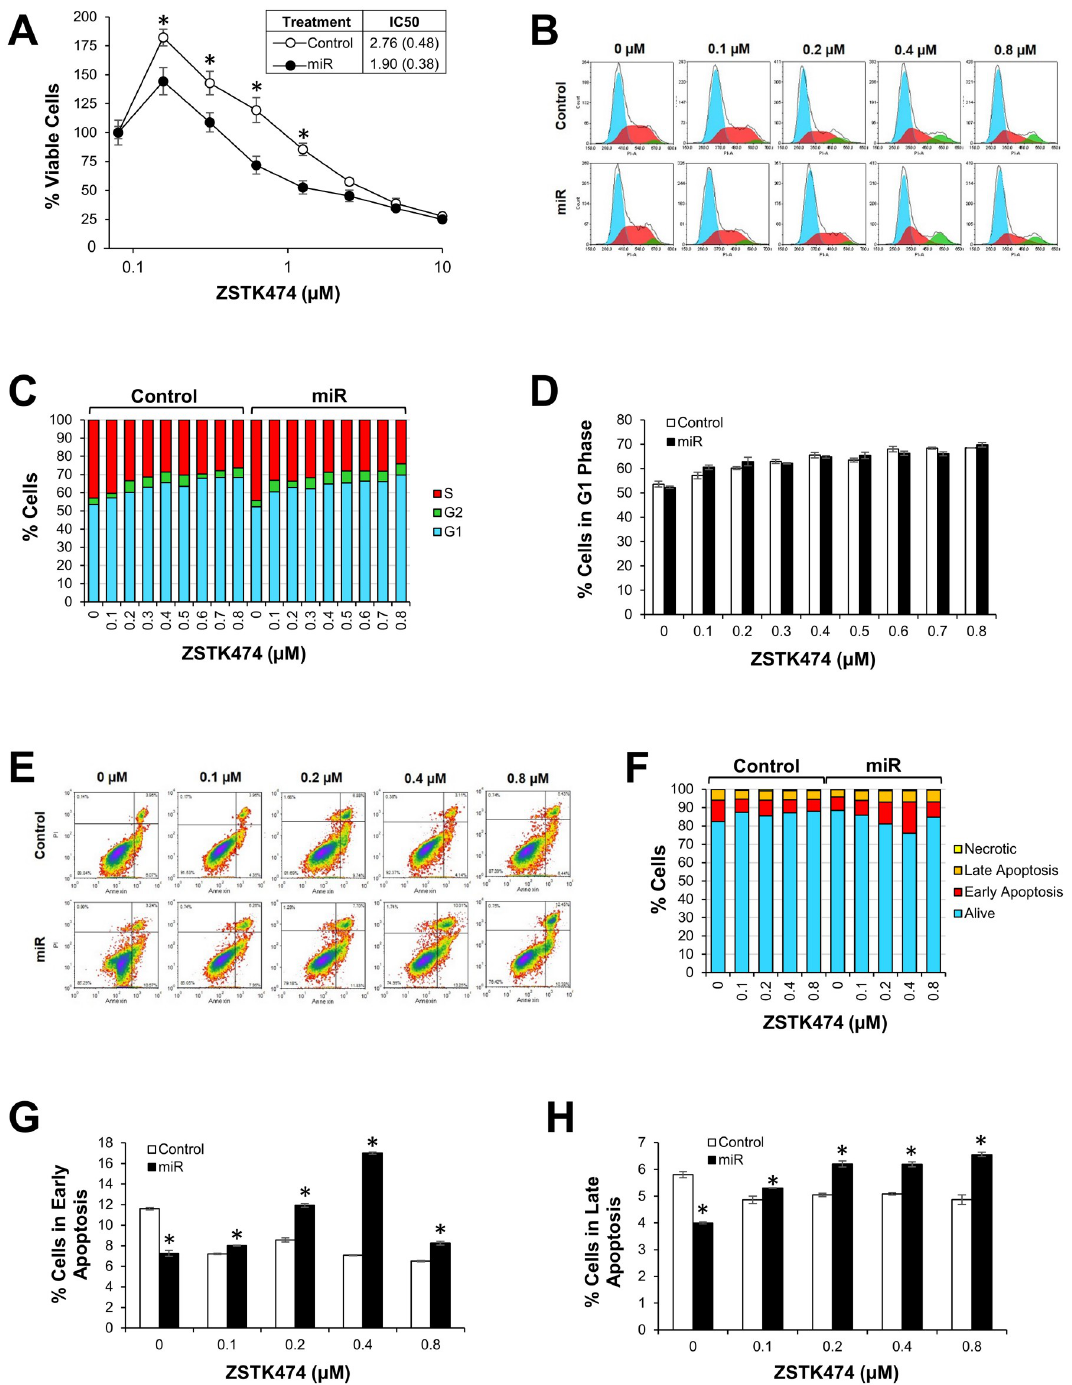
Fig 7. miR-105 and miR-767 facilitate sensitivity to ZSTK474. (A) ZSTK474 effects in A549 cells with miR-105 and miR-767 mimics or a negative control miRNA. Values are normalized to cells treated with 0 μ M ZSTK474. IC50 values represent the ZSTK474 concentration that results in a half-maximal response. (B, C) Cell cycle analysis by flow cytometry. (D) The percentage of cells in the G1 phase. (E, F) Apoptosis was quantified using flow cytometry. Representative density plots show cells that are alive (lower left quadrant), in early apoptosis (lower right quadrant), in late apoptosis (upper right quadrant), and necrotic (upper left quadrant). miR- 105 and miR-767 upregulate (G) early apoptosis and (H) late apoptosis upon ZSTK474 treatment. Data are presented as mean ± SEM. � p <